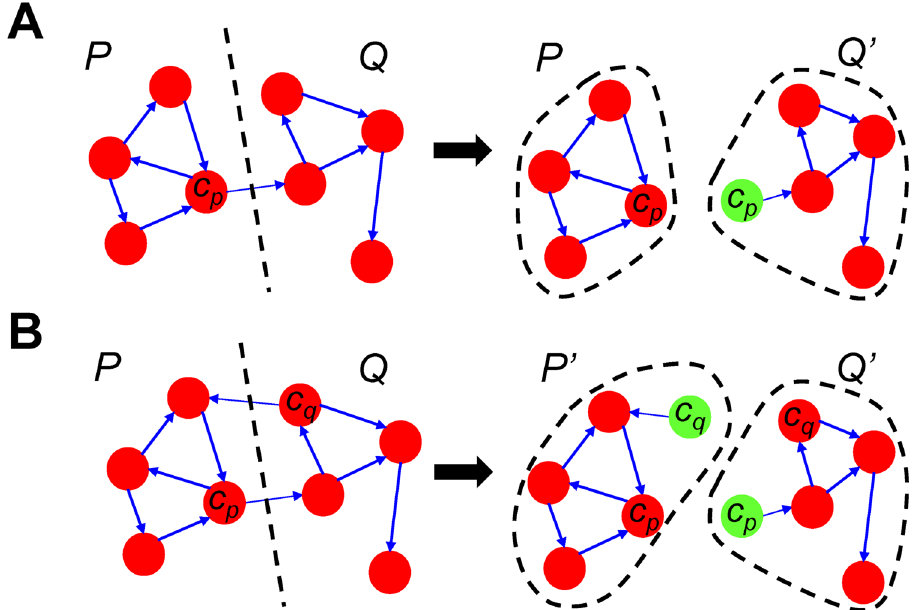
Fig 1. An intuitive idea of partitiong a Boolean network into two blocks and composing steady states found independently. A: A Boolean network G can be partitioned into two blocks P and Q which are connected by c p . Then, we construct two subnetworks P and Q 0 where Q 0 = Q [ { c p }, and c p is used to combine the local steady states found in each subnetwork. B: When there also exists a set of edges from c q of Q , we construct two subnetworks P 0 and Q 0 where P 0 = P [ { c q } and Q 0 = Q [ { c p }. Both c p and c q are used to combine the steady states of